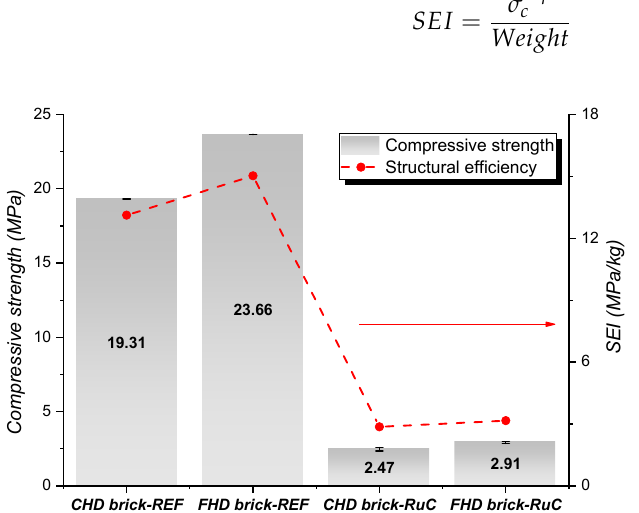
Figure 17. Compressive strength and SEI values for developed hollow bricks.